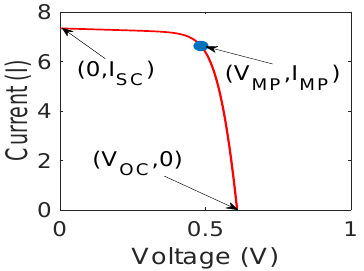
Figure 4. I – V characteristic of a PV